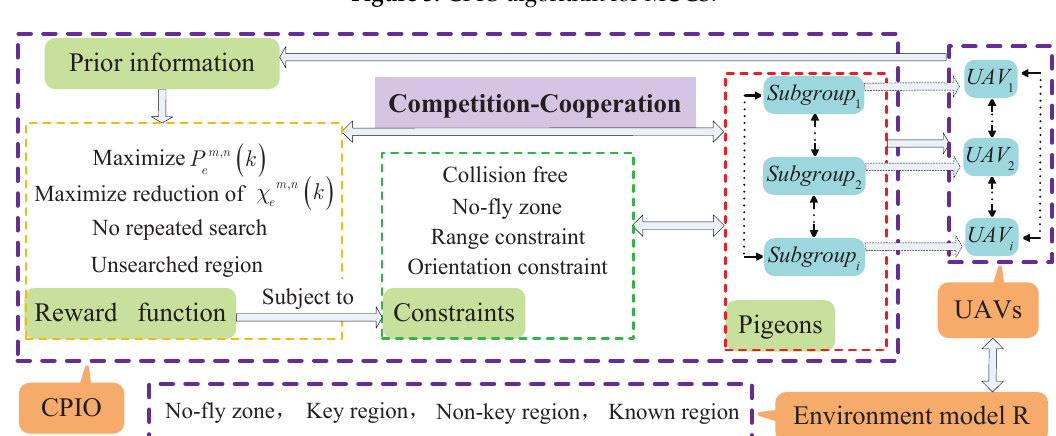
Figure 4. Schematic diagram of MUCS based on cooperation-competition